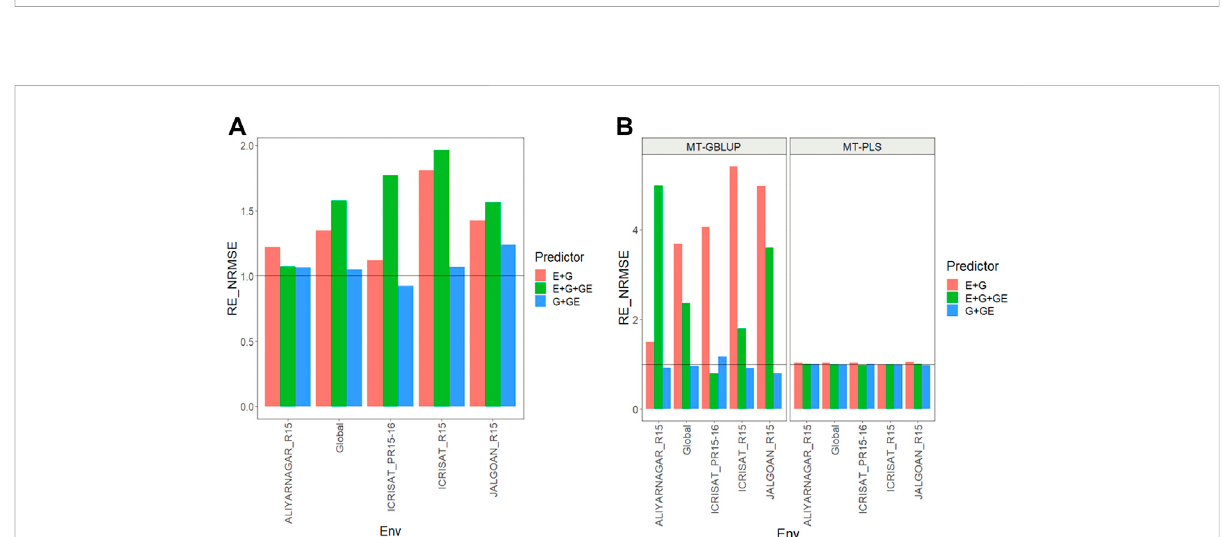
FIGURE 2 (A) Relative ef fi ciency in terms of normalized root mean square error (RE_NRMSE) computed by dividing the NRMSE under the multi-trait best linear unbiased predictor model (MT-GBLUP) by the NRMSE of the multi-trait partial least square regression method (MT-PLS). Prediction performanceisreportedacrosstraitsforeachenvironmentandacrossenvironments(Global)indataset2(Groundnut),alsowiththreepredictors(E+ G,E+ G + GEand G + GE). WhentheRE_NRMSE > 1theMT-PLSoutperform intermsof prediction performance (lower NRMSE) theMT-GBLUP method. (B) Relative ef fi ciency in terms of normalized root mean square error (RE_NRMSE) computed by dividing the NRMSE of either the UT best linear unbiased predictor model (UT-GBLUP) or UT partial least square regression method (UT-PLS), by the NRMSE of either MT-GBLUP or MT-PLS method.Predictionperformanceisreportedacrosstraitsfor eachenvironmentandacrossenvironments (Global)indataset2(Groundnut), also with three predictors (E + G, E + G + GE and G + GE). When the RE_NRMSE > 1 the multi-trait method outperform in terms of prediction performance (lower NRMSE) the UT